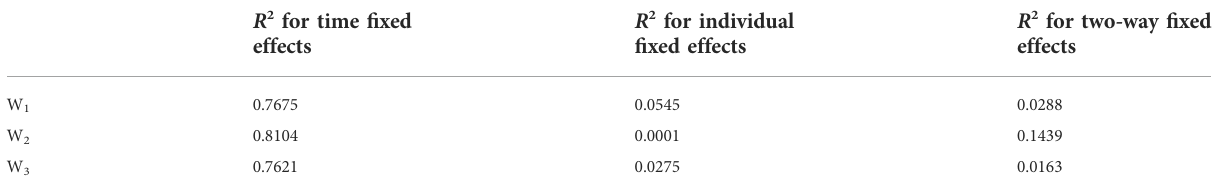
TABLE 4 R 2 comparison of time fi xed effects, individual fi xed effects, and two-way fi xed